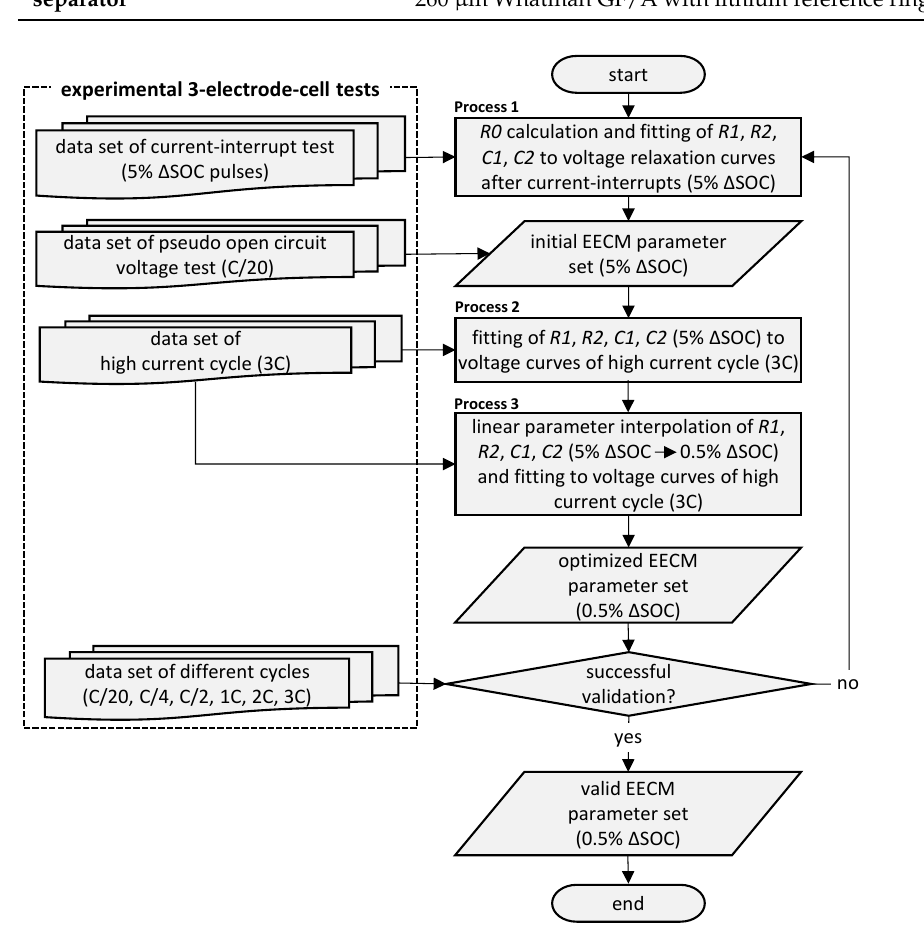
Figure 2. Flow chart of the novel Electrode Equivalent Circuit Model (EECM) parameterization approach with two RC branches for every electrode. Different experimental tests with 3-electrode cells are required for the parameterization. The three-step fitting process with parameter interpo- lation enables a fine SOC resolution for precise simulation fidelity. The values in brackets are the specifications of the applied parameterization for this